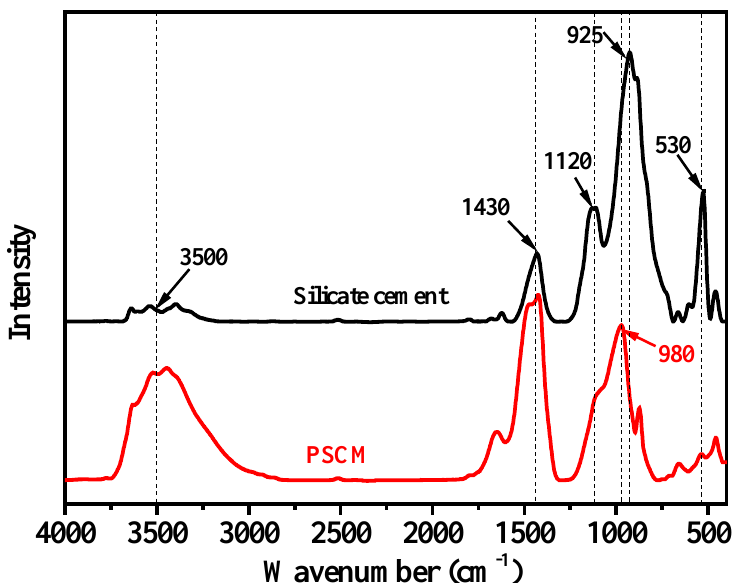
Figure 2. FT - IR spectra of silicate cement and PSCM based on the hot–dry casting